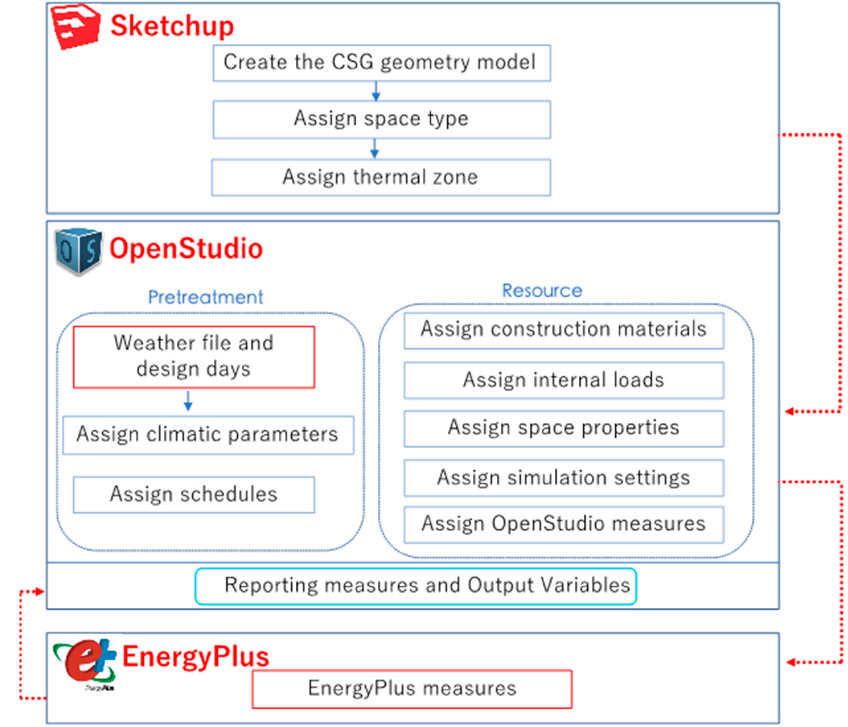
Figure 4. Flowchart for CSG simulation procedure.